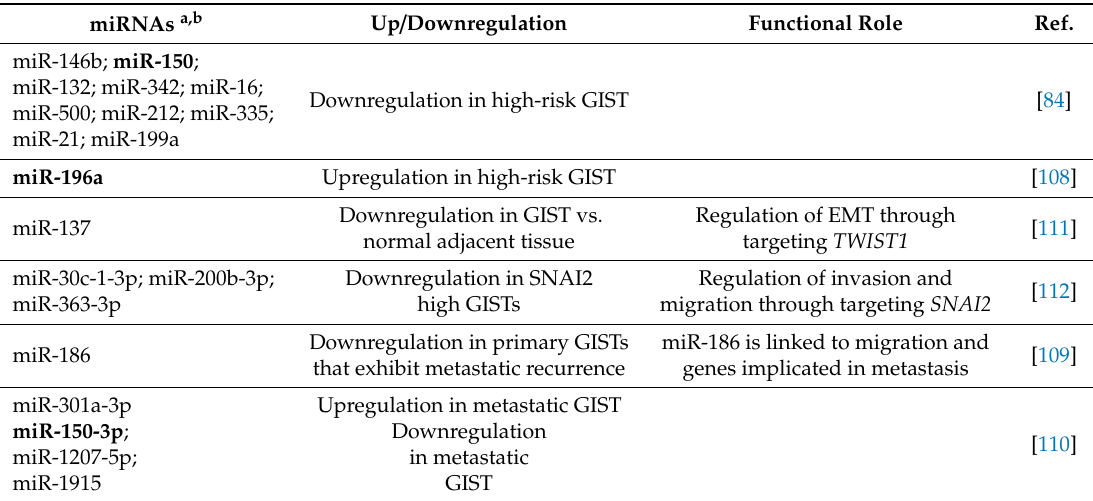
Table 2. MicroRNAs Associated with Metastasis in Gastrointestinal Stromal Tumors. miRNAs a,b Functional Role